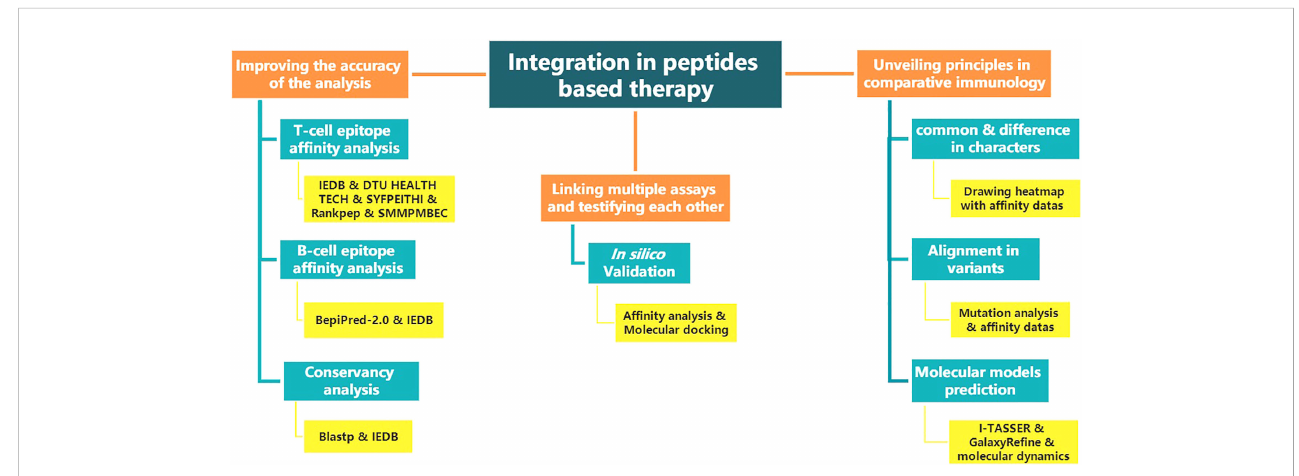
FIGURE 1 The structure diagram of recommendatory integration strategy. The orange is the purpose, blue is the method and yellow is the tool